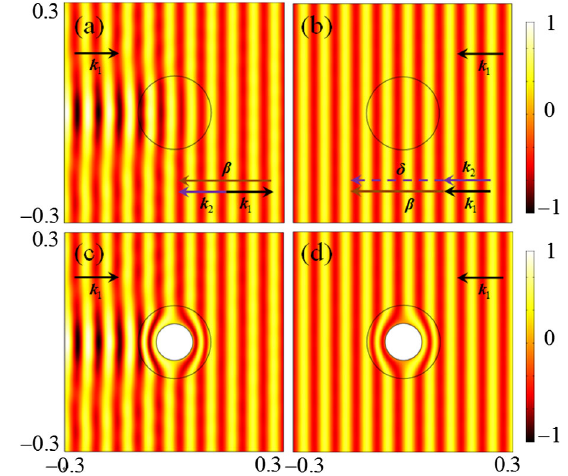
FIG. 3. The pressure-field maps in (a),(b) the virtual space and (c),(d) the physical space for a one-way invisible PT -symmetric cloak. In (a) and (c), where the plane wave is incoming from the left, a strong backscattered reflection can be observed due to the satisfied phase matching, and therefore, the observers on the left can sense the existence of the cloak. However, in (b) and (d), where the plane wave is incident from the right, the waves propagate without any scattering due to phase mismatching, and thus, an arbitrary object is perfectly concealed in the white region. The wavelengths of incident waves are λ ¼ 0 . 0572 m.